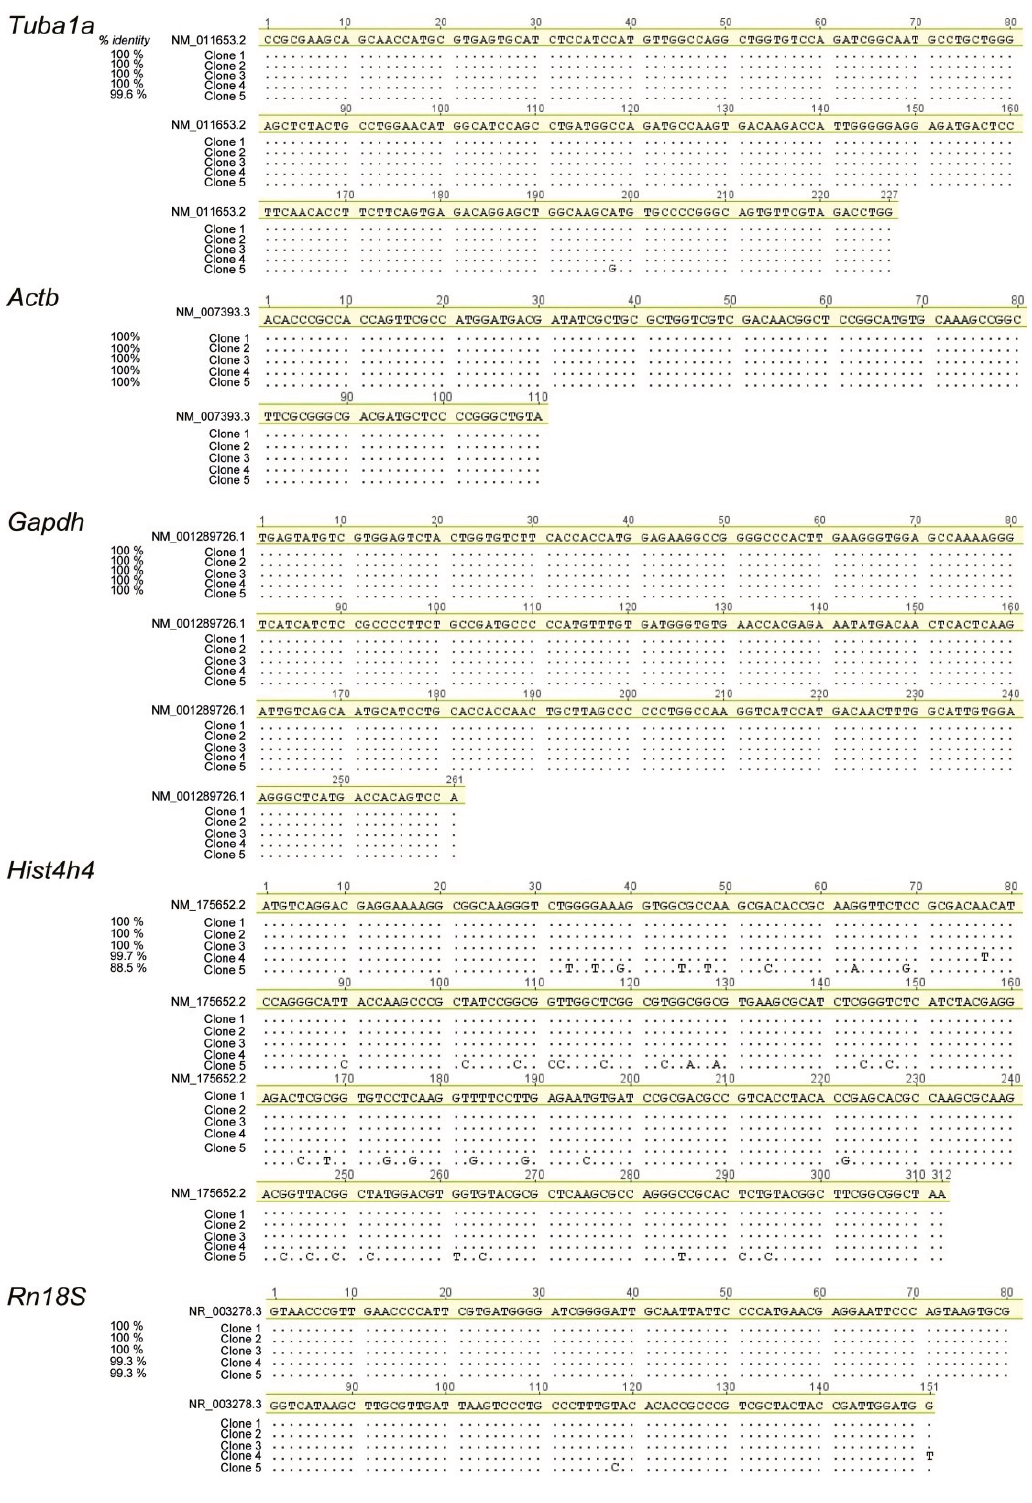
Figure 3. Sequence identity of the PCR products for the five reference genes evaluated in this study. Five plasmid clones (Clone 1–5) containing the PCR products of each of the reference genes evaluated in this study were compared against the reference sequence available at NCBI (Highlighted in yellow). Dots represent bases identical to the reference sequence while mismatches are indicated. Percentage of identity (% identity) is indicated for each